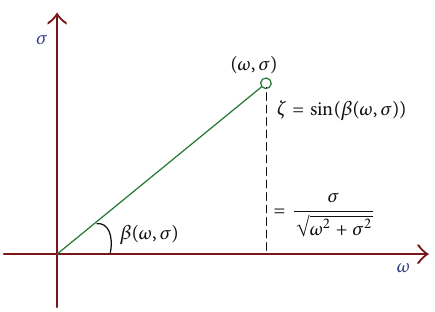
Figure 1: Schematic 2D representation of the vibration